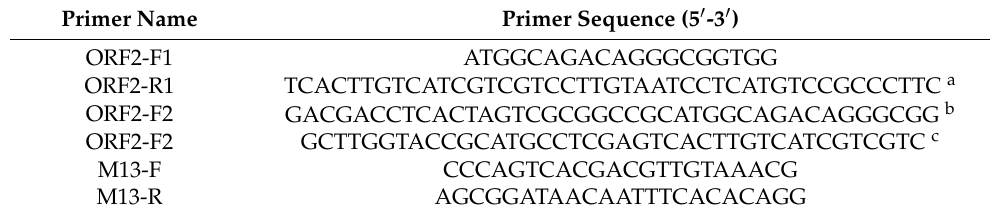
Table 1. Sequences of primers used in this study.